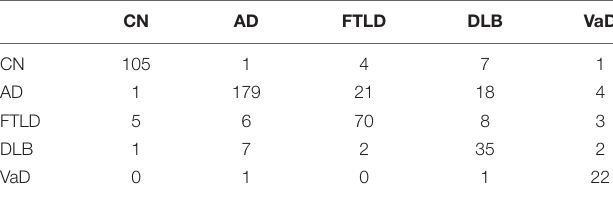
TABLE 4 | Confusion matrix when all the measurements are used. CN AD FTLD